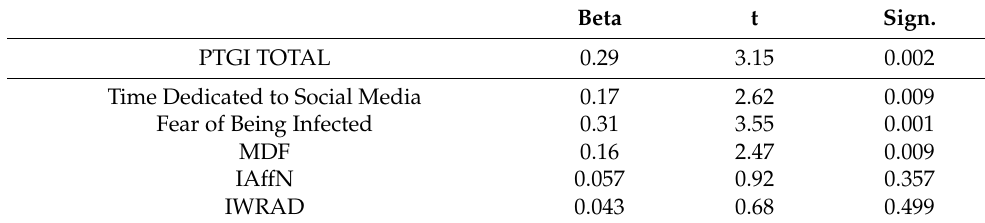
Table 2. Model derived from the linear regression analysis.